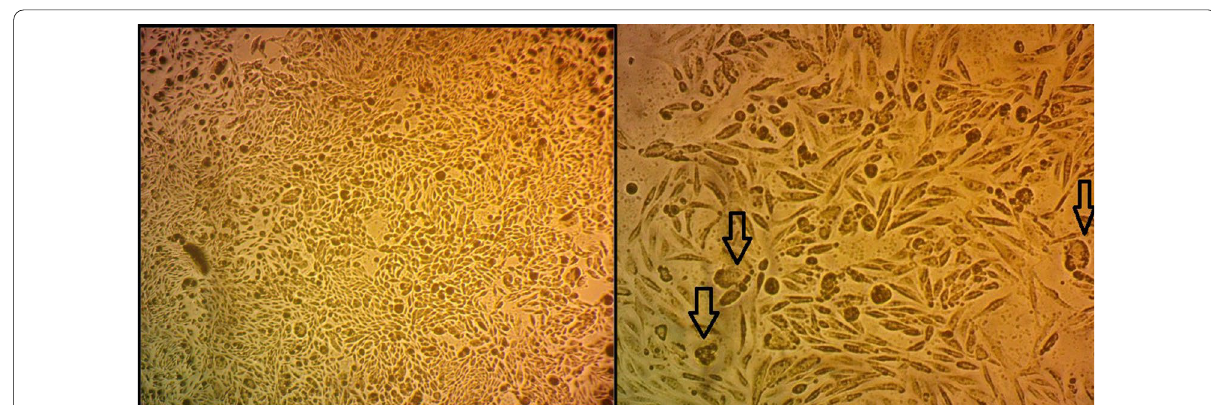
Fig. 4 Photomicrograph of HNO97 cells cultured in 200 µg/mL apricot oil (